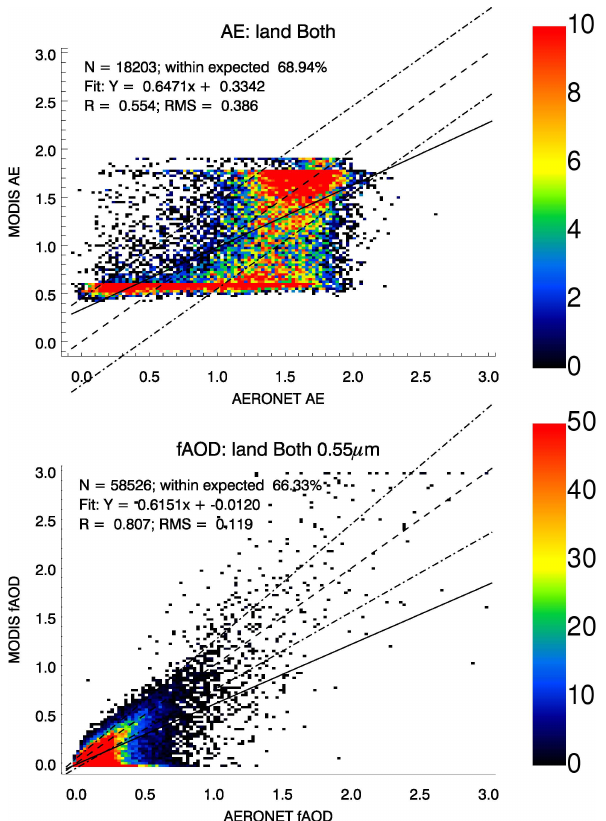
Fig. 2. MODIS-derived 0.47/0.65µm AE (top) and 0.55µm fAOD (bottom) collocated with analogous AERONET parameters, for both (the union of) Terra and Aqua datasets. Data are sorted accord- ing to ordered pairs (AERONET, MODIS) of AOD in 0.025 inter- vals, so that color represents the number of cases (color bars) having that particular ordered pair value. For each panel, the dashed, dot- ted and solid lines are the 1-1 line, EE, and the linear regression of the pre-sorted scatterplot, respectively. Text at the top describes the number of collocations (N) , the percent within expected error, the regression curve, correlation (R) , and the RMS error of the fit. The AERONET AE is derived from AOD that has been interpolated (quadratic) to MODIS wavelengths, whereas the AERONET fAOD was derived with the ONeill et al. (2003) deconvolution technique. EE for AE is ± 0.4, EE for fAOD is ±